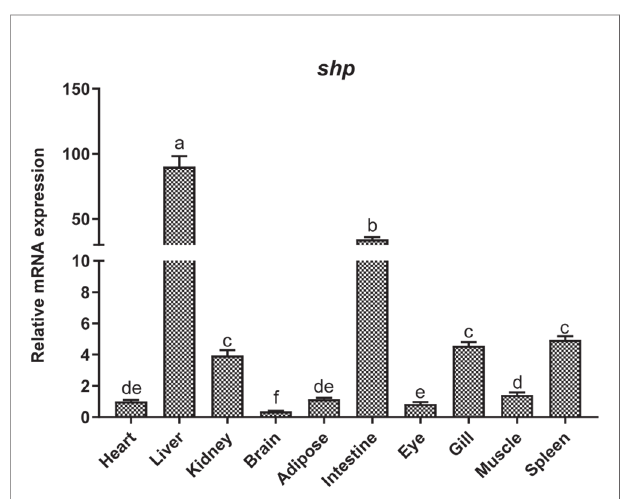
FIGURE 4 | Tissue distribution of SHP in large yellow croakers. Data are presented as means ± SEMs, n = 3 replicate experiments. Signi fi cance was evaluated by one-factor ANOVA followed by Duncan ’ s multiple range test. Labeled means without a common letter differ, P <